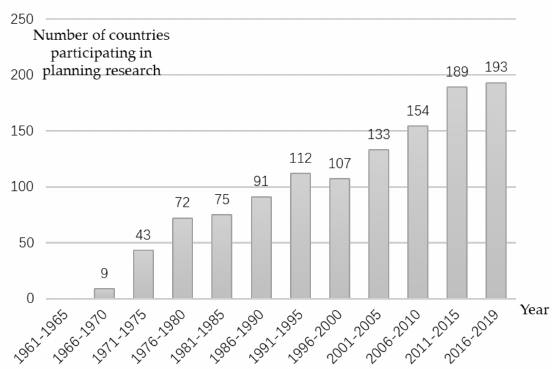
Figure 1. Growth in the number of countries contributing to and participating in planning research since the 1950s [30]. Source: based on data from Web of Science. Note: Due to (1) international conventions, (2) statistical methods of WoS system, and (3) different names of different countries in history, statistical standards of different countries are different. For the convenience of statistics, the author deals with them as follows: Czech is calculated as Czech Republic or Czechoslovakia (Czech = Czechoslovakia + Czechoslovakia); The four regions of the United Kingdom, England, Scotland, Wales, and Northern Ireland, all calculated as United Kingdom. The historical East and West Germany, the German Democratic Republic and the Federal Republic of Germany, were united as Germany. The Soviet Union in history was counted as